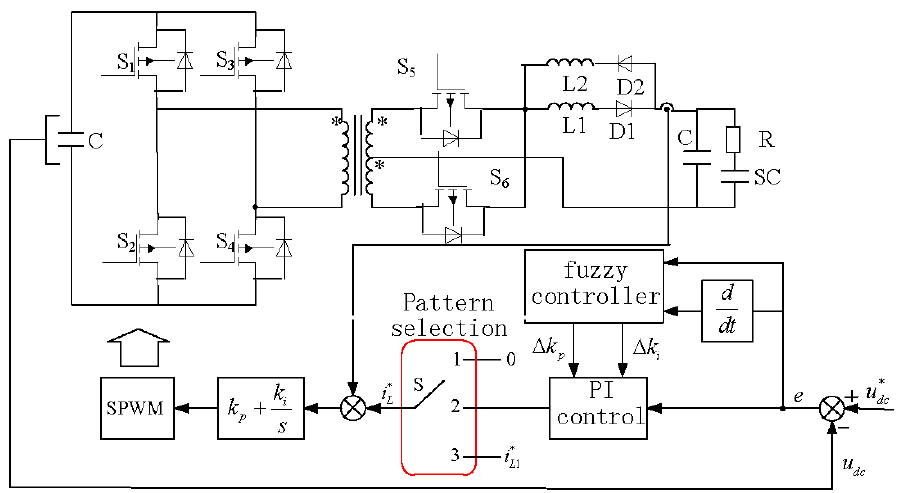
Figure 5. Fuzzy adaptive PI control of energy storage .